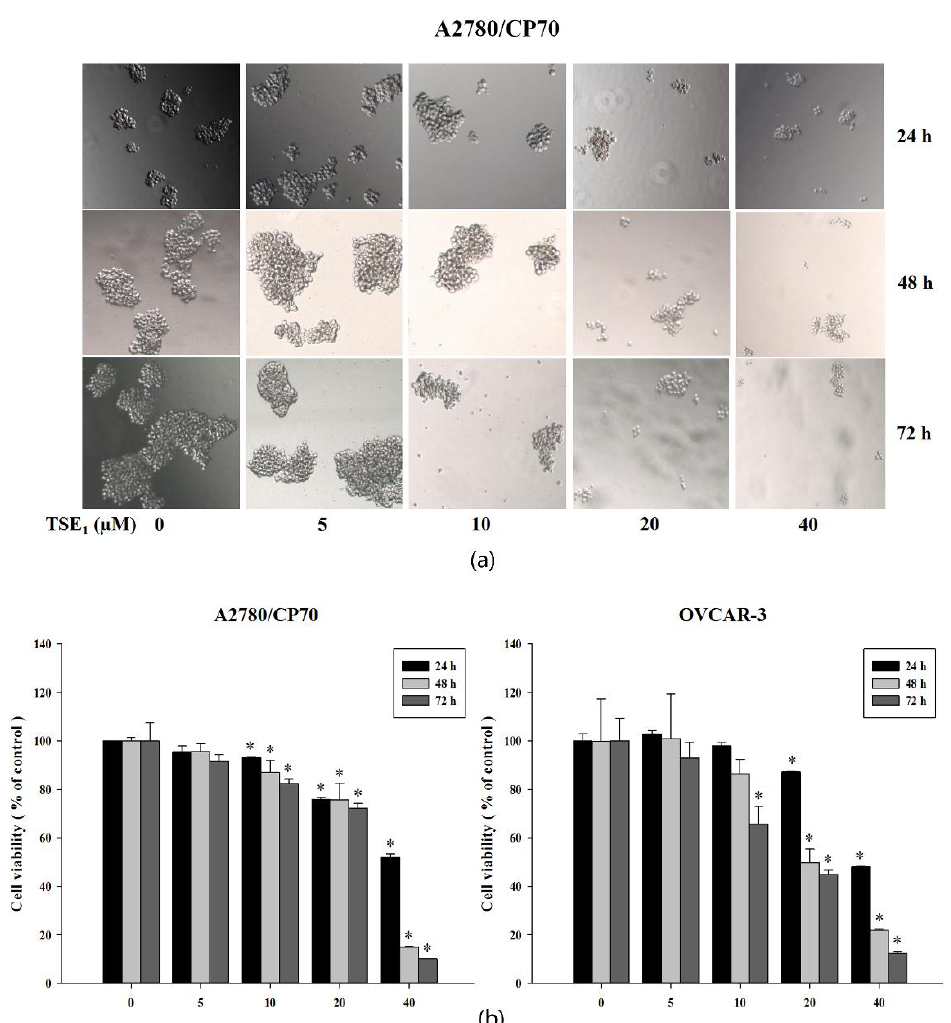
Figure 5. Effects of TSE 1 on cell growth of sphere cells (3-weeks) from A2780/CP70 and OVCAR-3 cell lines. ( a ) cell morphology observation after treatment with various concentrations of TSE 1 for 24, 48 and 72 h, respectively, via fluorescent microscopy (100 × ); ( b ) TSE 1 inhibited cell viability of sphere cells with treatment 0 to 40 µ M for 24, 48 and 72 h, respectively; cell viability was determined via MTS assay. Data was expressed as percent of control (without TSE 1 treatment) and shown as mean ± SD ( n = 5), * = p ≤ 0.05, significant difference compared to control at the same treatment time.